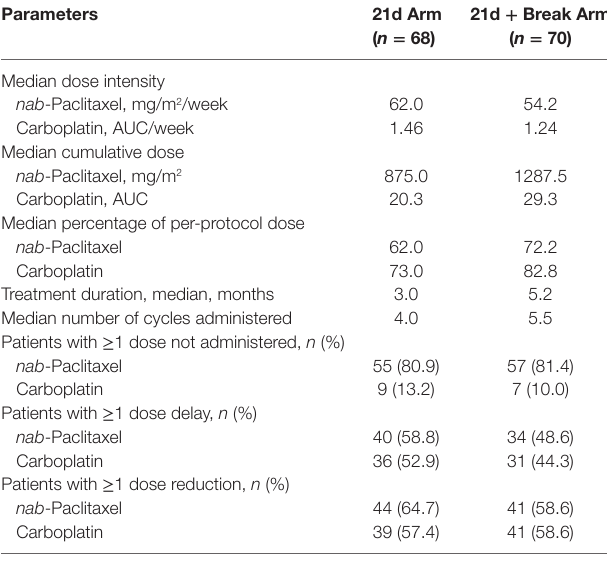
TaBle 1 | Baseline